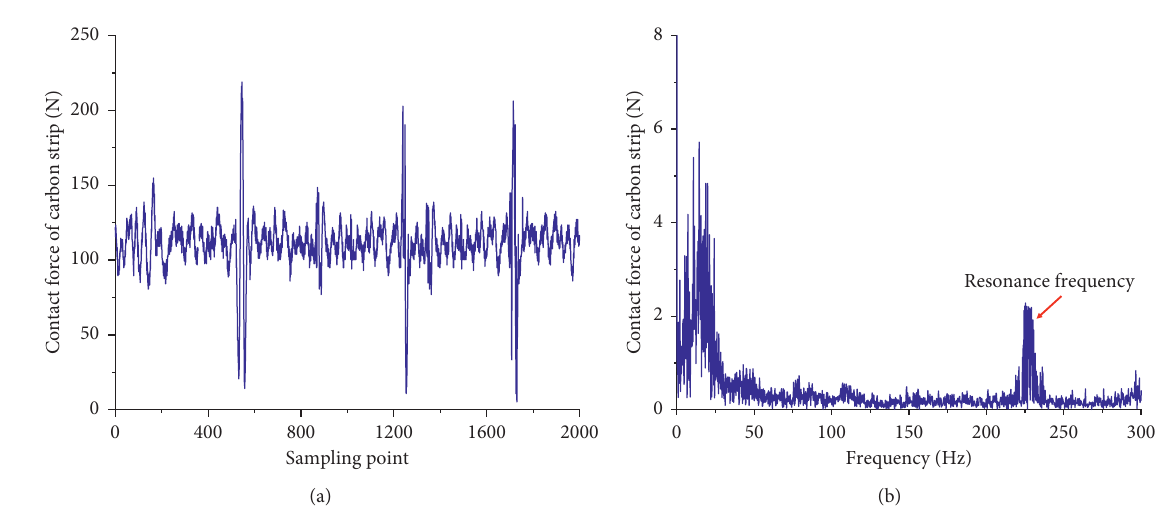
Figure 12: Time-domain diagram and spectrum of contact force between carbon strip and catenary.